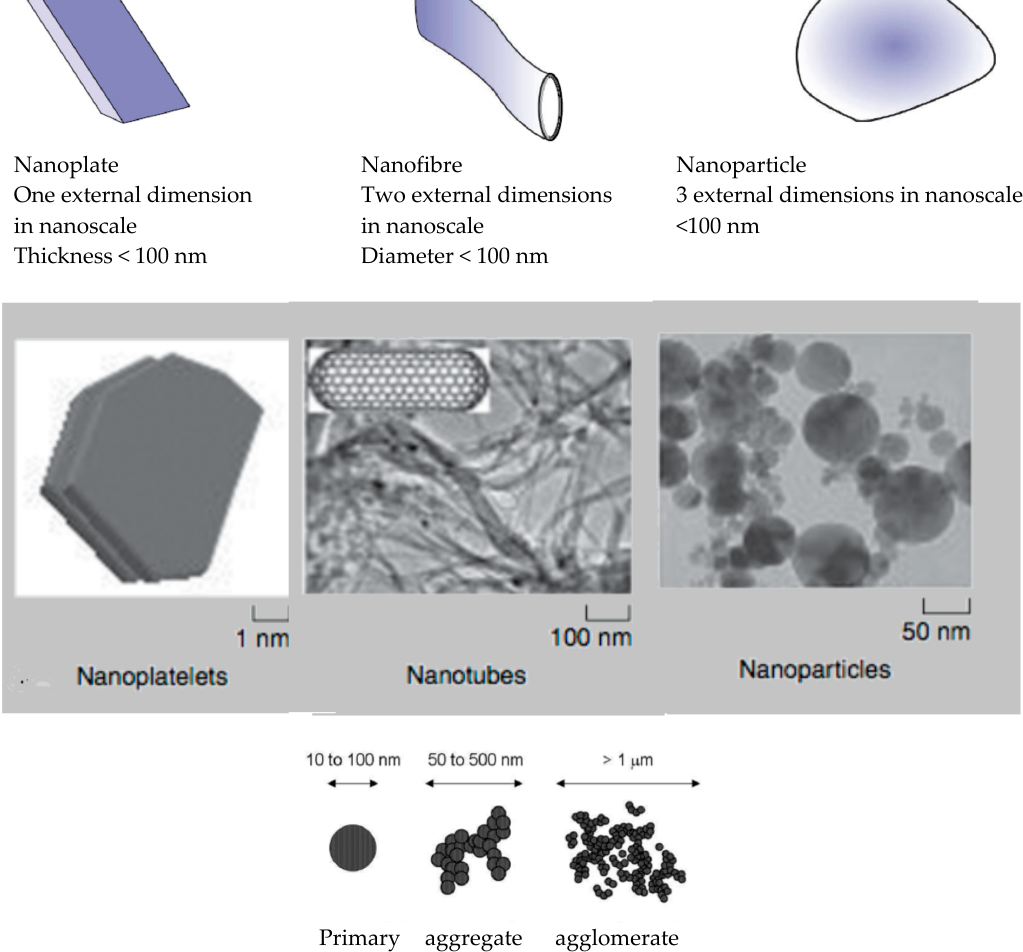
Figure 1. Representative images for nanofillers for nanocomposites. adapted from [17–19].